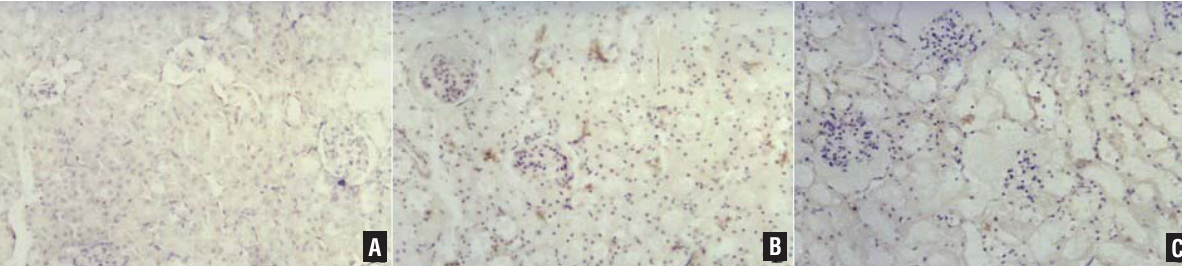
Figure 6 - Histology fi gures of E-Selectin expression in the three groups. A) Control; B) IR;